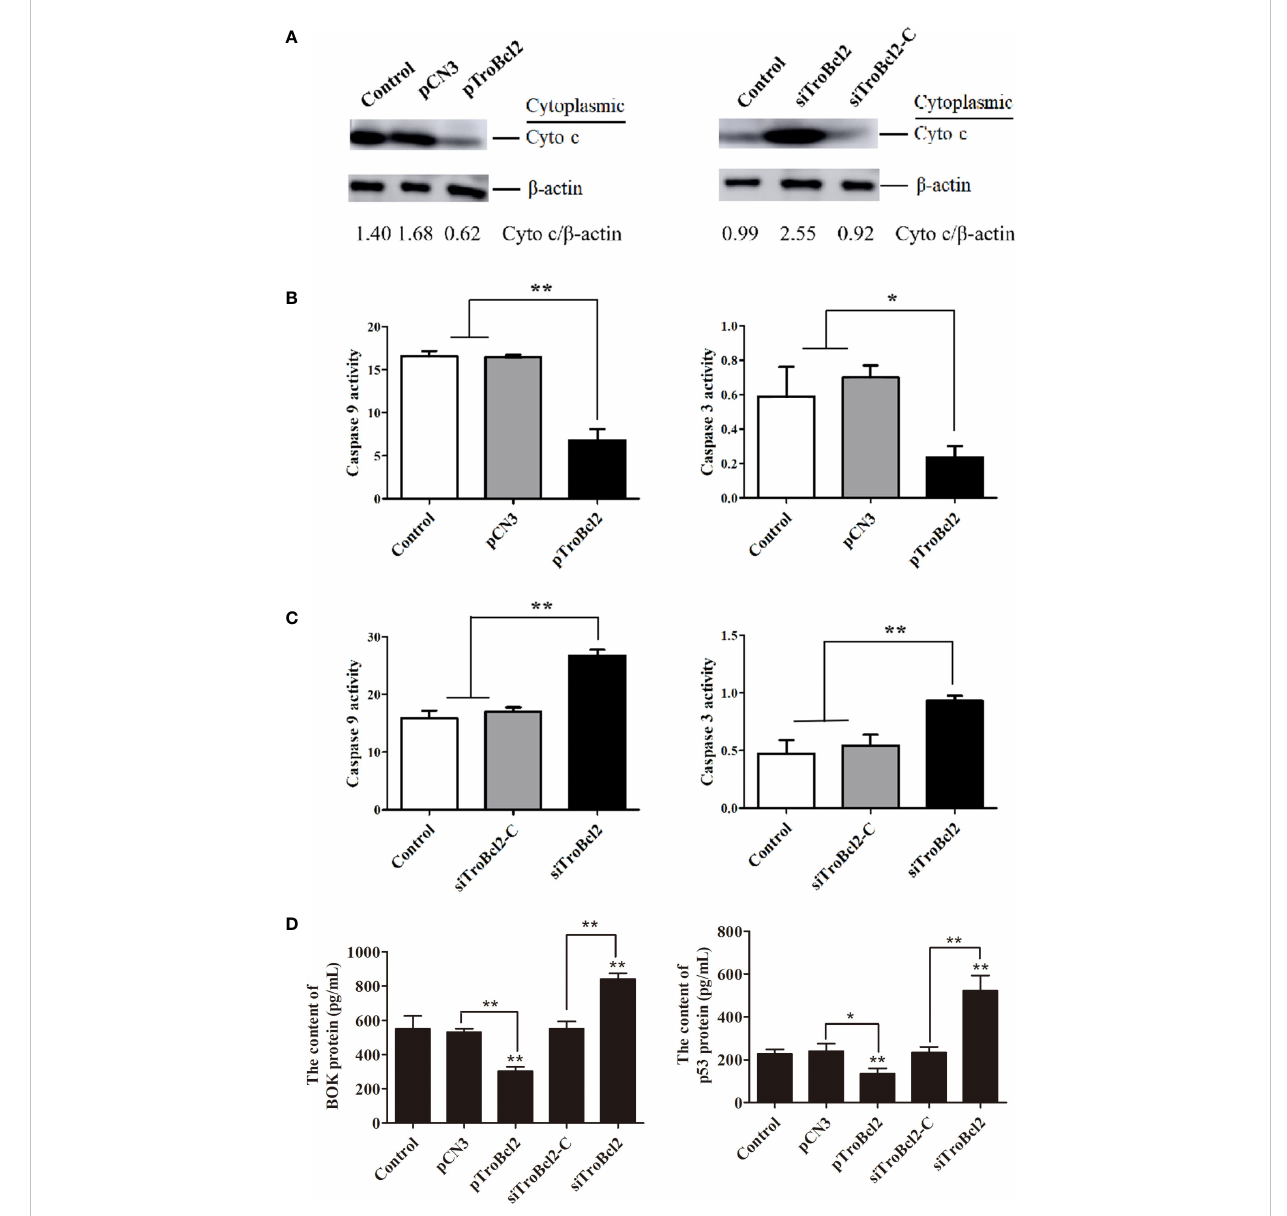
FIGURE 7 Effect of TroBcl2 overexpression and knockdown on the cytochrome c release into cytoplasm, caspase activities, and BOK and p53 protein levels following LPS stimulation. GPS cells transfected with pTroBcl2 and pCN3 or siTroBcl2 and siTroBcl2-Cfor 24 h were treated with LPS. Non- transfected cells treated with LPS were as the control. Then, the cytochrome c protein level in cytoplasm was detected by western blotting, and b - actin was used as the internal control (A) . The gray values of cytochrome c/ b -actin are calculated by Image J and shown on the last line. The levels of caspase 3 and caspase 9 activation in cells were detected by the Caspase 3 and Caspase 9 Activity Assay Kits (B, C) . The protein levels of BOK and p53 were detected by ELISA assay (D) . Error bars display means ± SD (N = 3). N, experimental number. ** P < 0.01, * P <